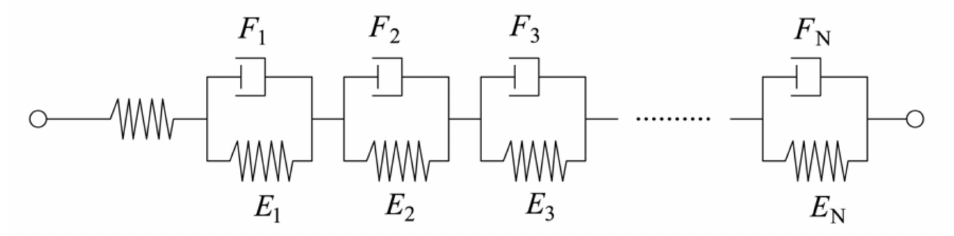
Figure 1. Kelvin–Voigt